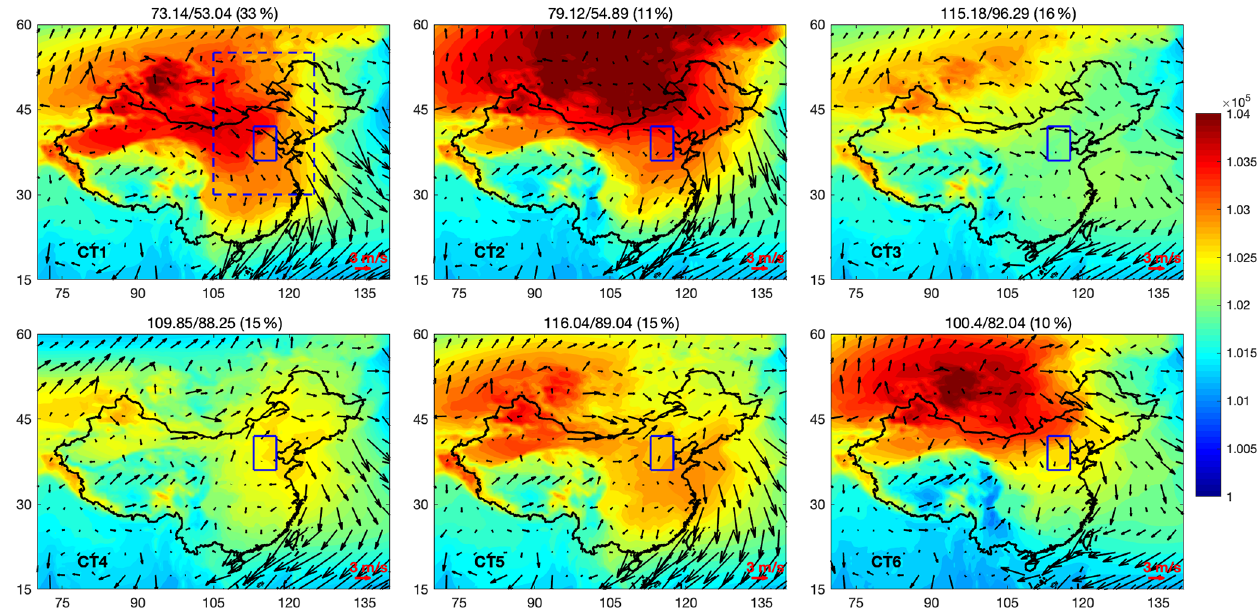
Figure 2. The distribution of sea level pressure (shaded, unit: Pa) and 10m wind fields (vector, unit: ms − 1 ) in each circulation type. The number over each subplot indicates the occurrence frequency of the specific circulation type. The solid blue box is the location of the BTH region. The daily mean geopotential height fields at 925, 850 and 500hPa over the dashed blue box (30–55 ◦ N and 105–125 ◦ E) were applied to the T-mode PCA method with the Cost733 toolbox. The region mean wind speed of each circulation type is shown in Table 2.